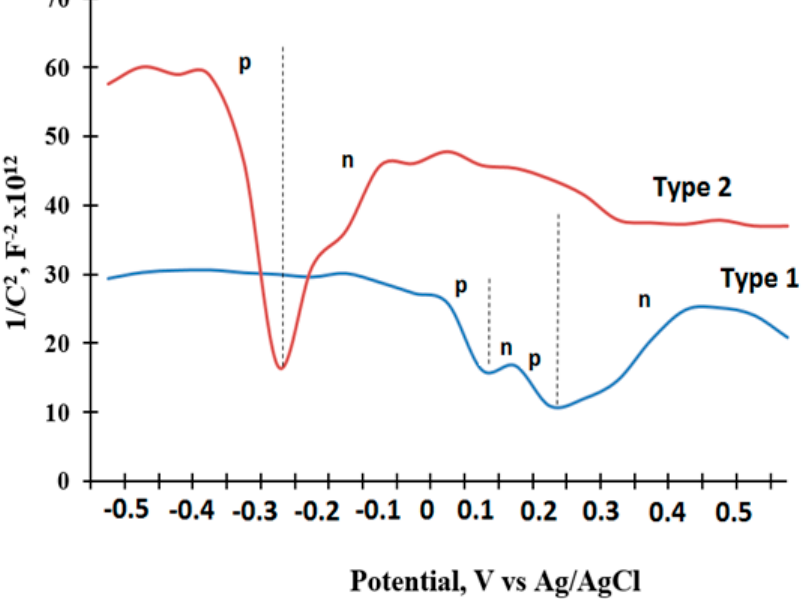
Figure 12. Mott ‒ Schottky plots for type-1 and -2 sensors under different applied